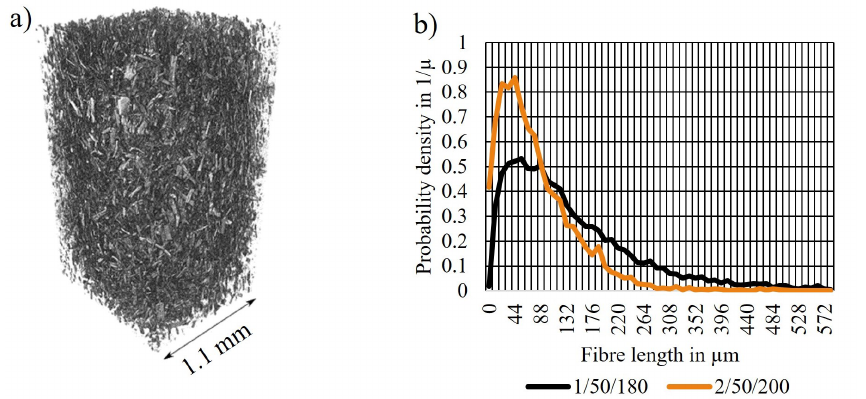
Figure 8. Results from X- µ CT. ( a ) Visualisation of series 1/50/180, ( b ) fibre length distribution of series 1/50/180 and